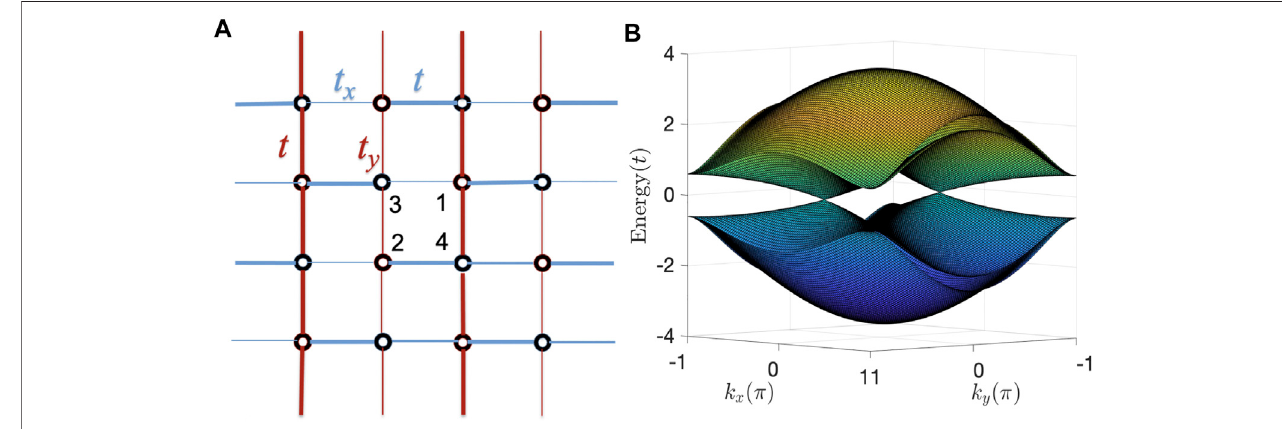
FIGURE 4 | (A) Schematic of the type-II 2D SSH lattice. Blue (red) thick and thin bonds mark alternately dimerized hopping amplitudes in x ( y )-direction. (B) The band structure with at pair of Dirac points. Her we take t x = 0.4 t , t y = 1.2 t